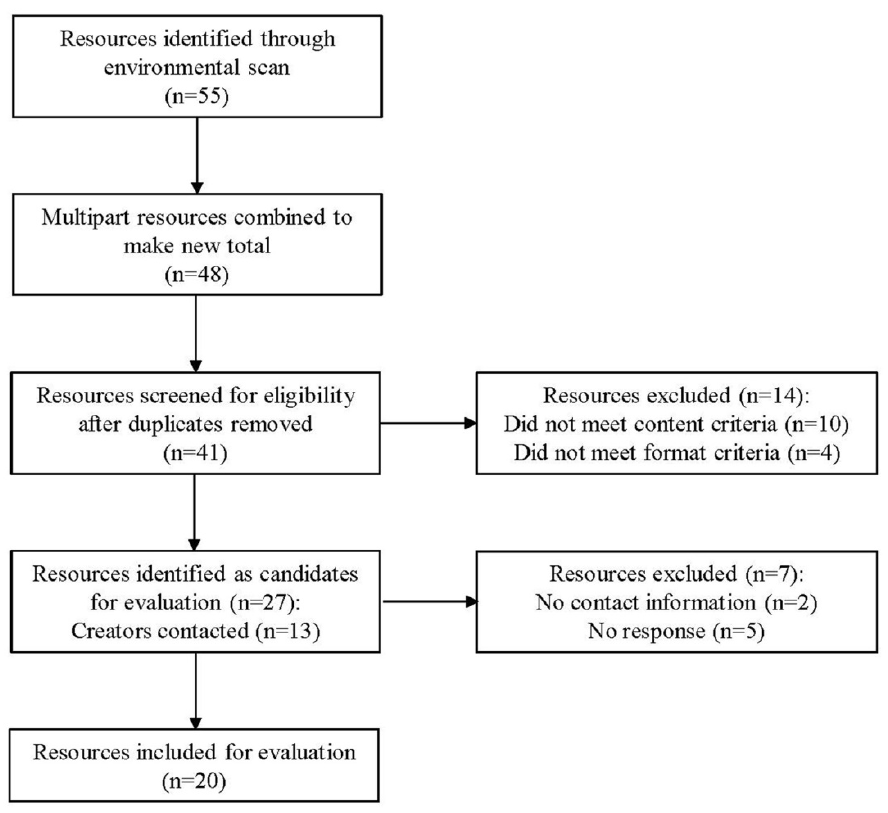
Figure 1 Environmental scan inclusion